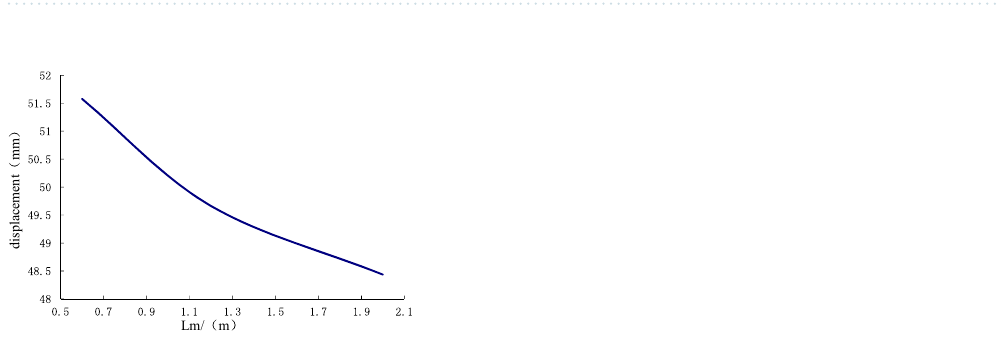
Figure 16. The effect of equivalent width D e (500–1500 mm) on the displacement of the anchor-pulling system.